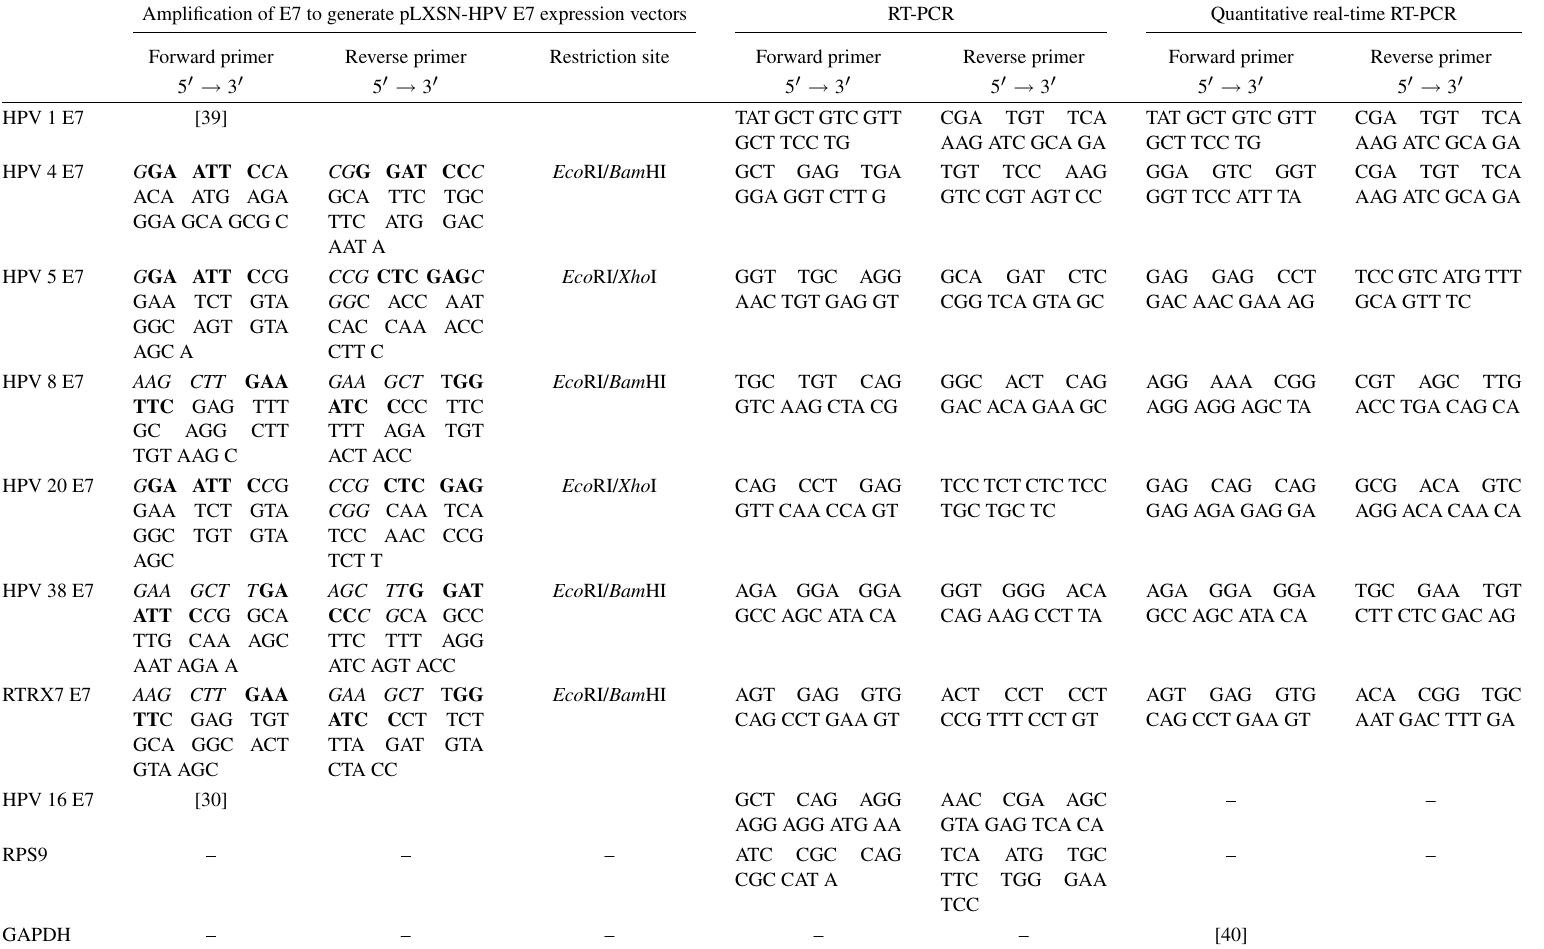
Primer sequences used to generate recombinant retroviruses and to examine E7 RNA expression Amplification of E7 to generate pLXSN-HPV E7 expression vectors RT-PCR Quantitative real-time RT-PCR Forward primer Reverse primer Restriction site Forward primer Reverse primer Forward primer Reverse